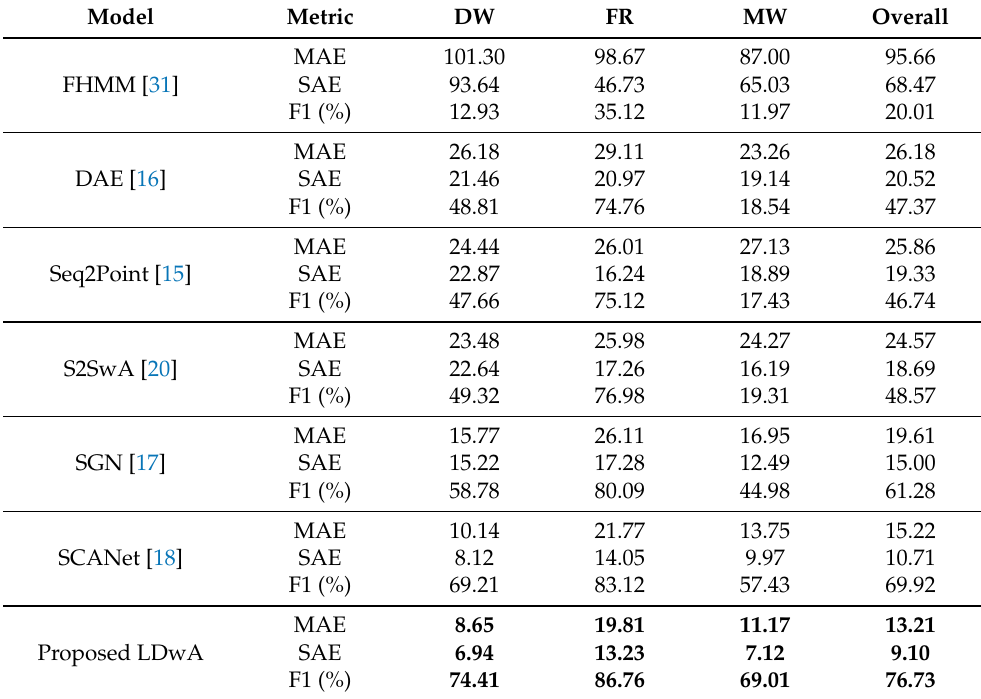
Table 2. Disaggregation performance for the REDD dataset. We report in boldface the best approach.